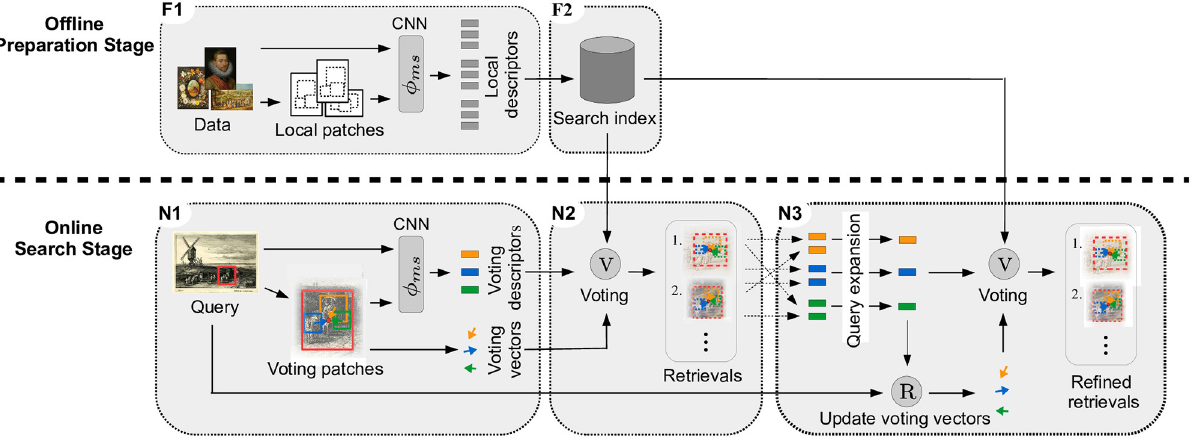
Fig 5. General structure of the retrieval algorithm. The retrieval algorithm consists of an offline preparation and an online search stage. During the offline preparation stage, features of local patches on multiple-scales are extracted for all images (F1). Then, they are compressed and stored in the search index (F2). During the online search stage, descriptors of discriminative local patches within the query region are extracted (N1). Their k-nearest neighbors across the whole dataset are determined, and our voting procedure aggregates multiple local matches to retrieval bounding boxes (N2). Finally, the results are refined using local query expansion and re-voting (N3). Please, see the text for more details. Image material is shared by Wikimedia Commons [5] either as public domain or under a CC0 license.